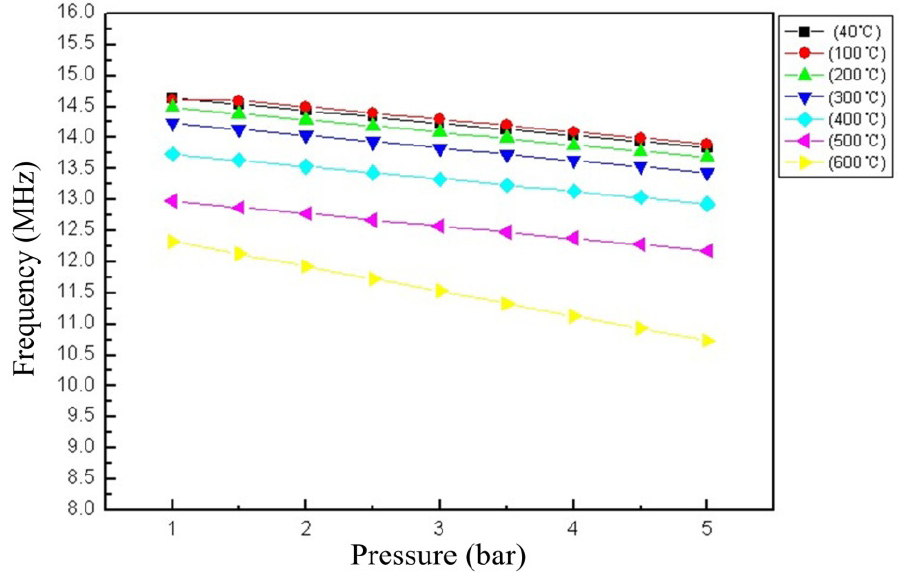
Figure 12. Resonant frequency of the sensor versus applied pressure from 1–5 bar as the temperature increases from room temperature to 600 °C.